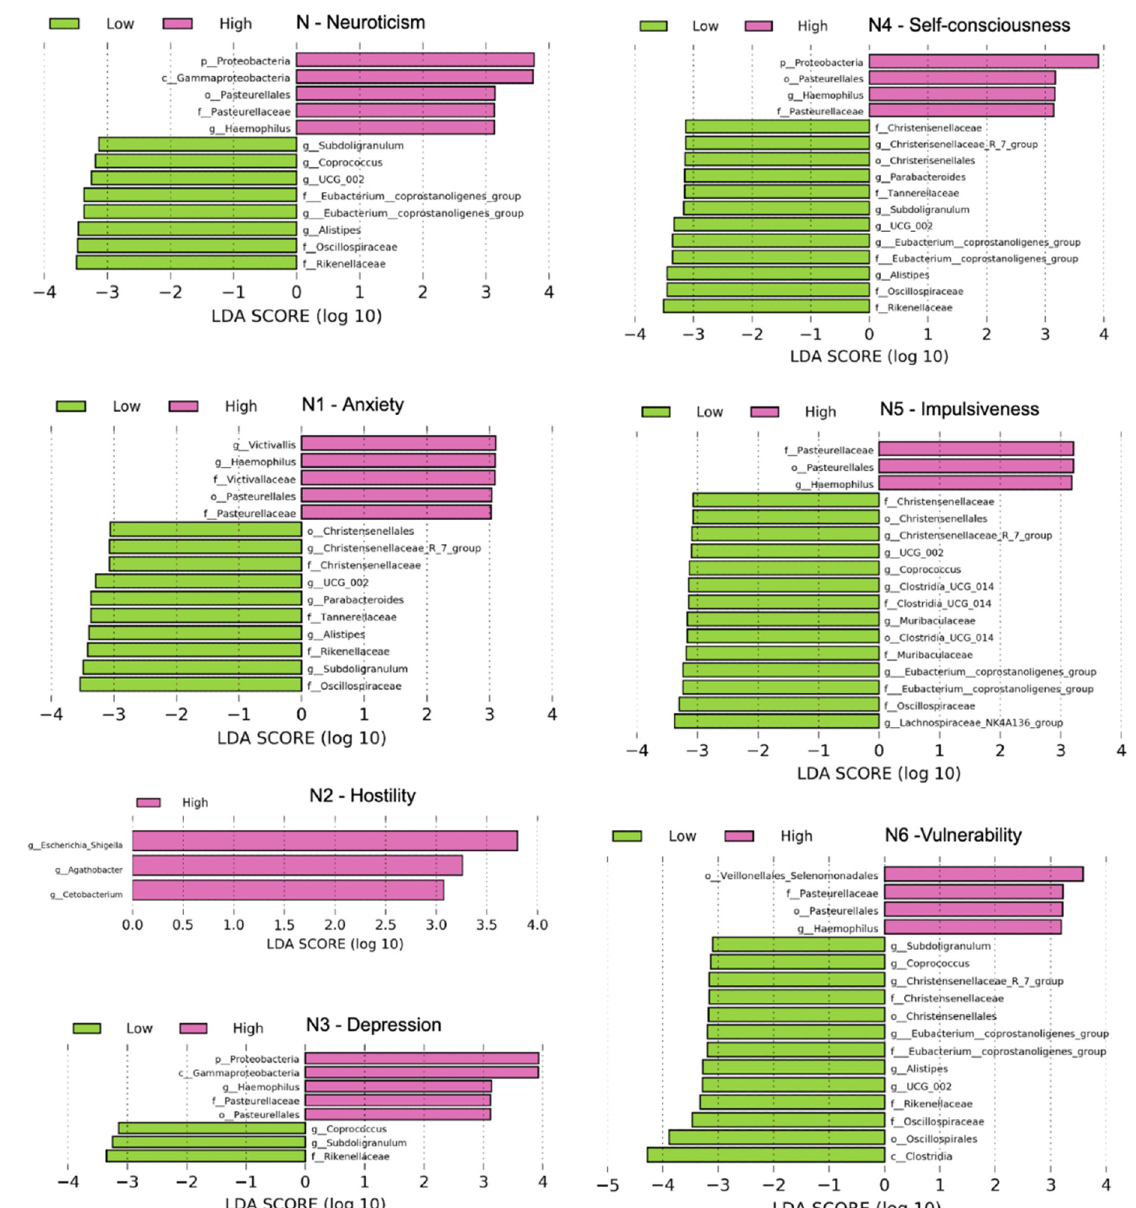
Figure 5. Differentially abundant bacterial taxa in fecal samples from the low and high groups of neuroticism scores. A forest plot showing taxa that were significantly differentially abundant between low (green) and high (pink) as determined using the Kruskal–Wallis test. LDA score (effect size) indicates significant differences in bacterial taxa (LDA score > 3.0); alpha value p < 0.05.